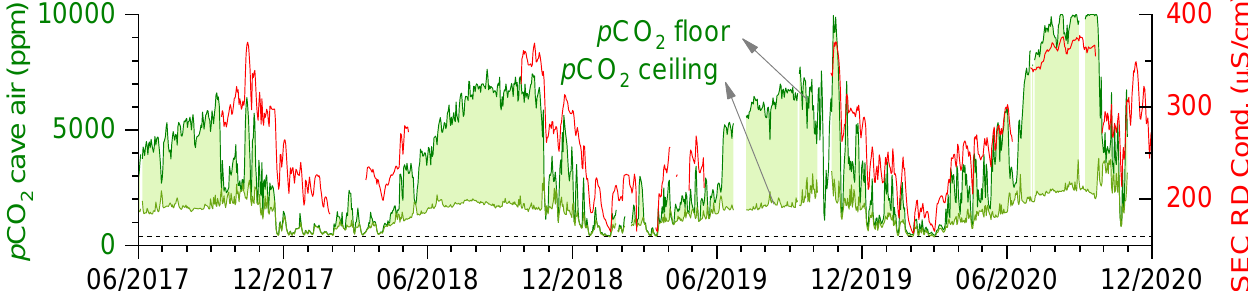
Figure 7. Time series of the daily p CO 2 fluctuations in the Red Hall at the floor (dark green) and ceiling (light green) compared to the SEC (red line) measured in the RD Cond. cup. The green shading represents the differences in the CO 2 concentrations between the floor and the ceiling of the Red Hall.